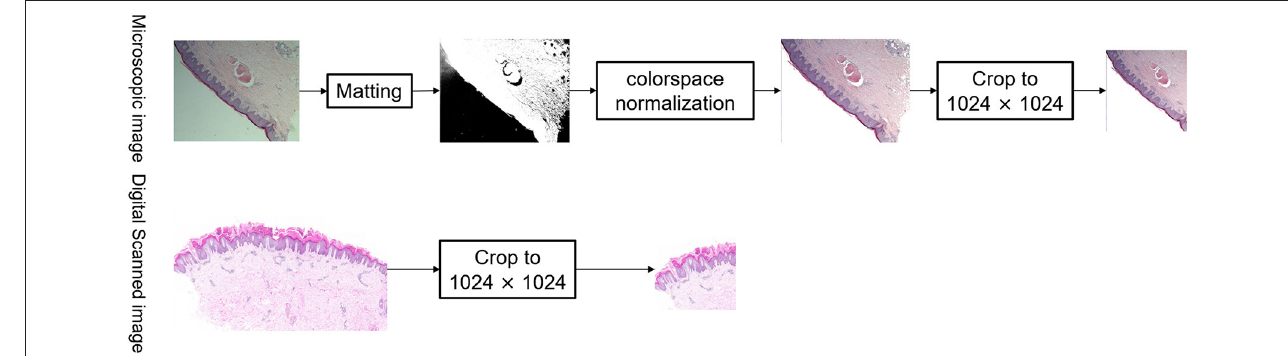
FIGURE 3 | Normalization of images.